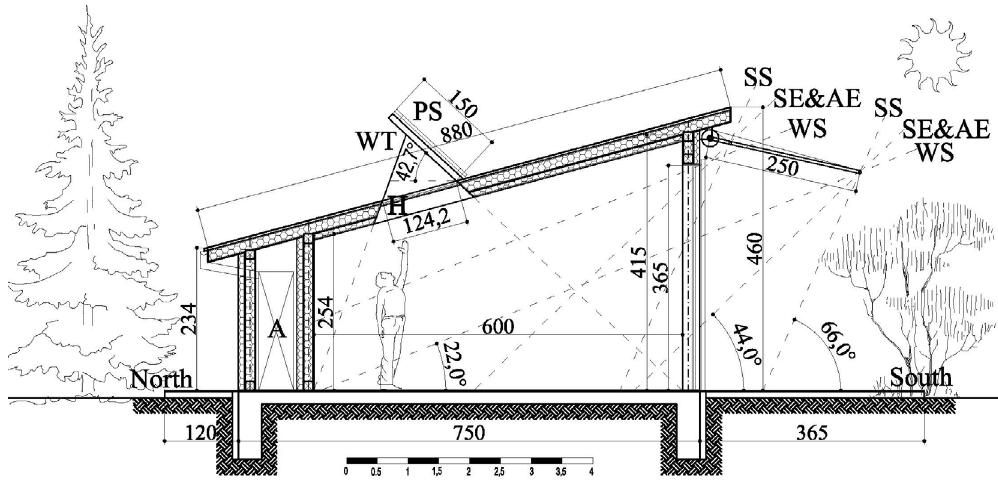
Fig. 4. General demonstrative section for the cheap type solar